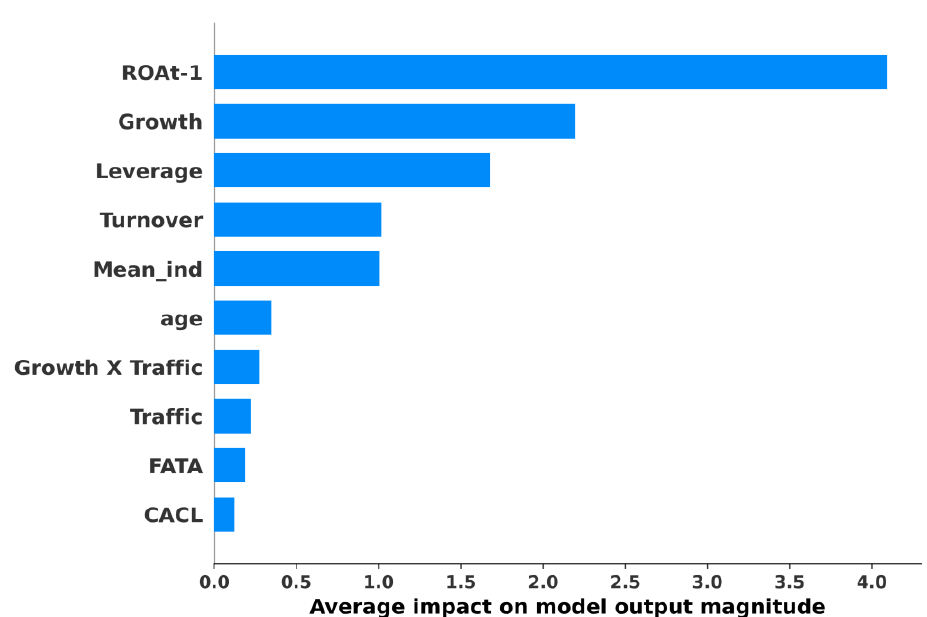
Figure 6. Features’ importance of factors affecting the profitability of firms for the DNN method and Model 3 (test sample).